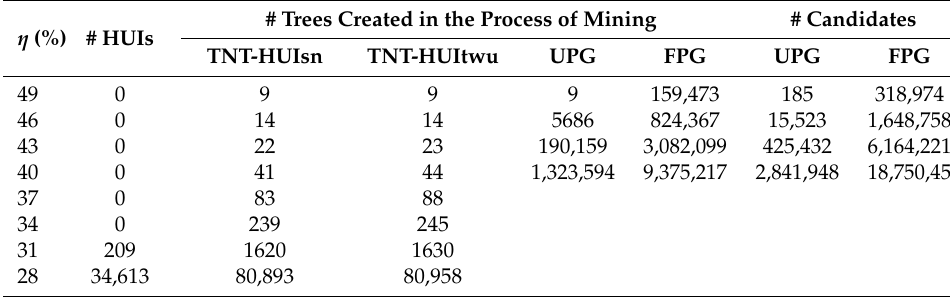
Table 6. Details analysis on the dataset connect.